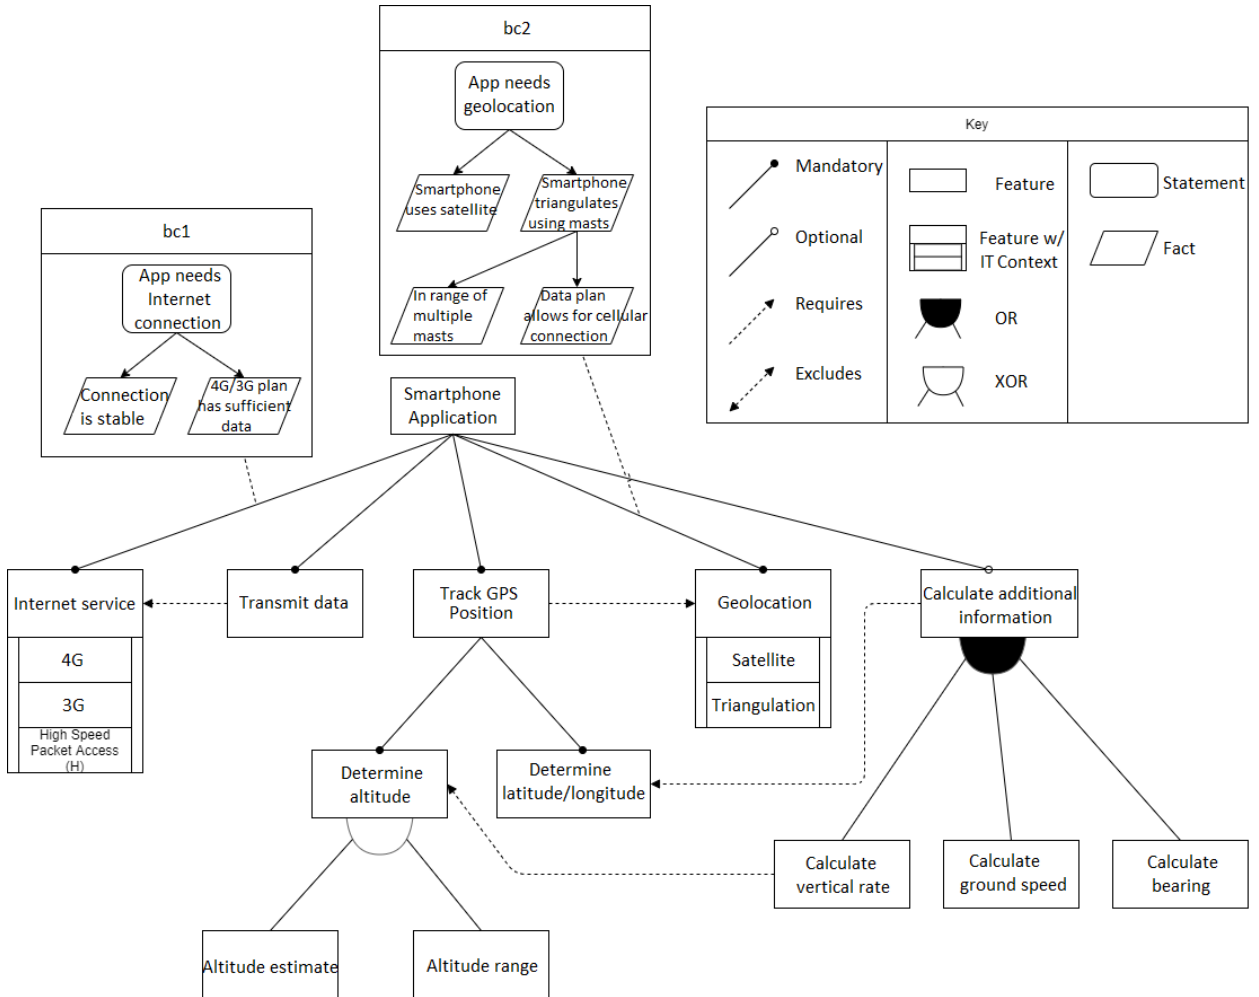
Figure 3. Feature model for the mobile